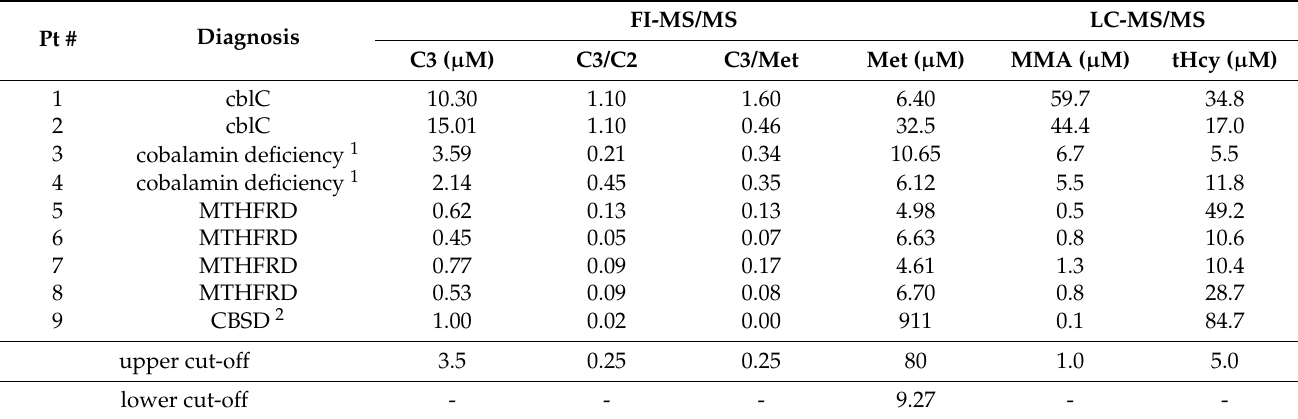
Table 3. Methylmalonic acid (MMA) and total homocysteine (tHcy) in DBSs of patients with positive results in